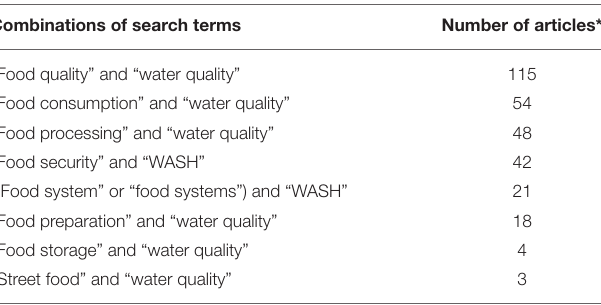
TABLE 3 | Results of the combination of specific search terms. Combinations of search terms Number of articles* “Food quality” and “water quality”